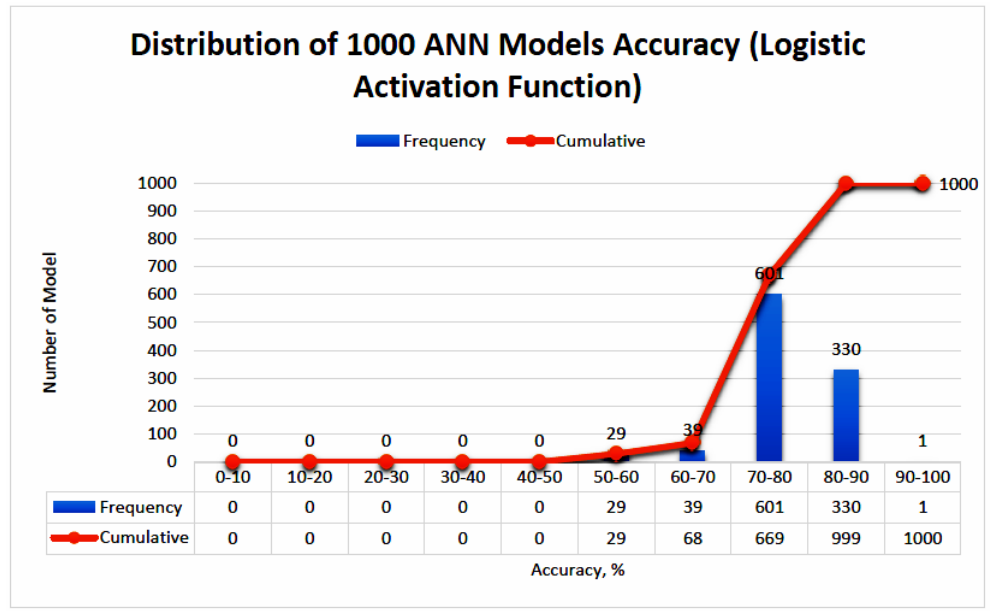
Figure 4. Histogram illustrating the distribution of accuracy among all 1000 ANN models using the logistic activation function.